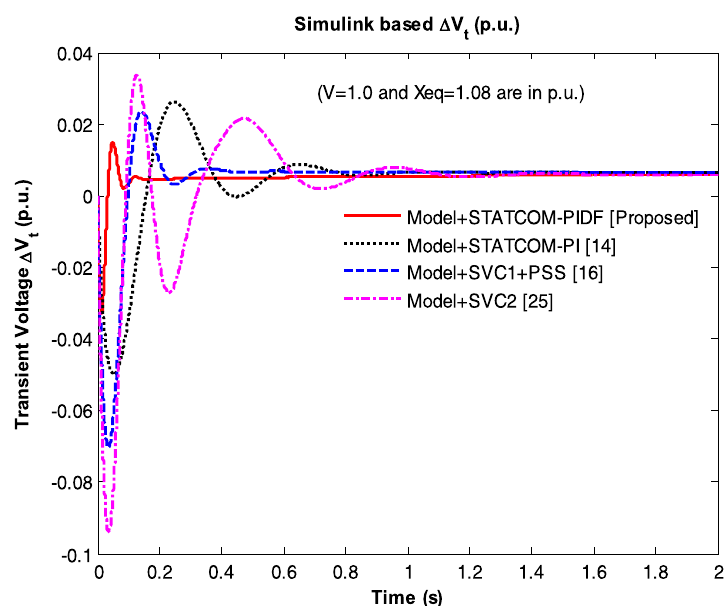
Fig. 9 Comparative study using different controllers with SOS optimization